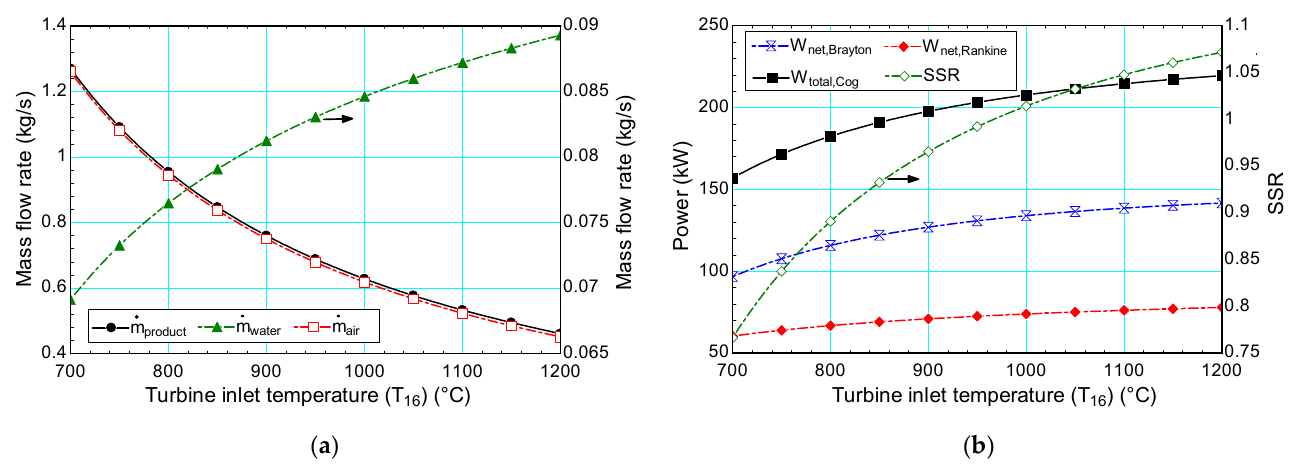
Figure 6. Turbine inlet temperature effect on: ( a ) Mass flow rate of exhaust gas, air, and water ( b ) self-sufficiency ratio and power production (total power requirement for the WWTP is 184.3 kW).